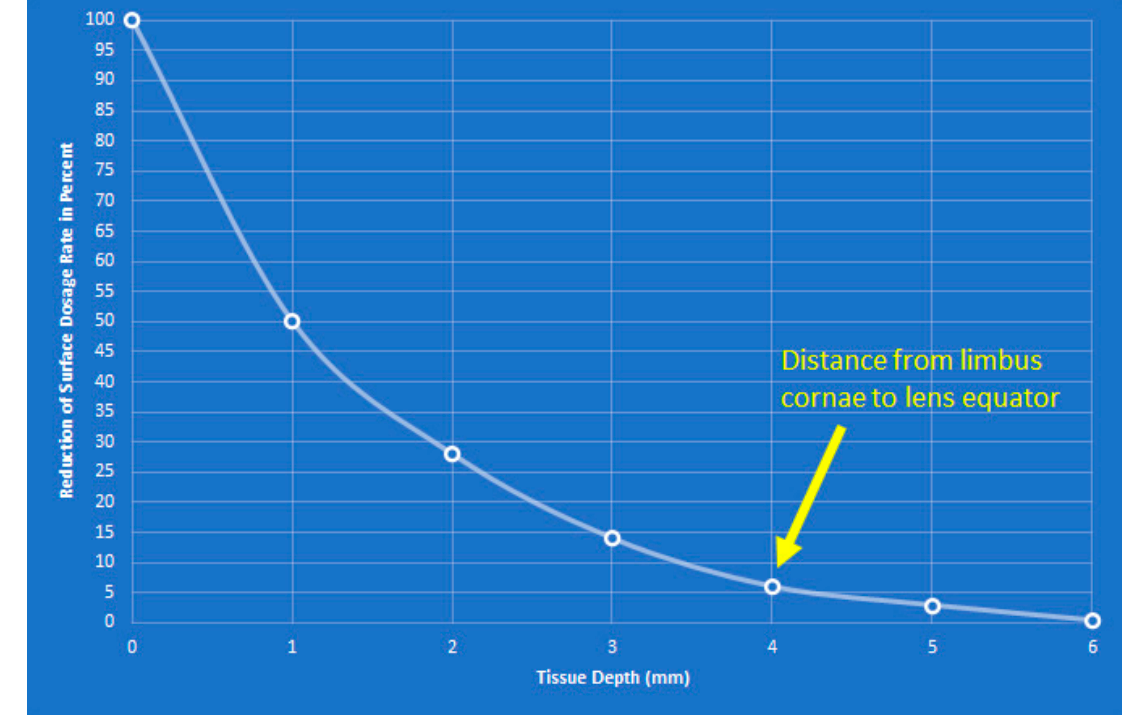
Figure 5. The diagram shows the penetration depth of beta radiation in the tissue. It can be seen that only 6% of the irradiation penetrates 4 mm, i.e., to the equator of the lens.